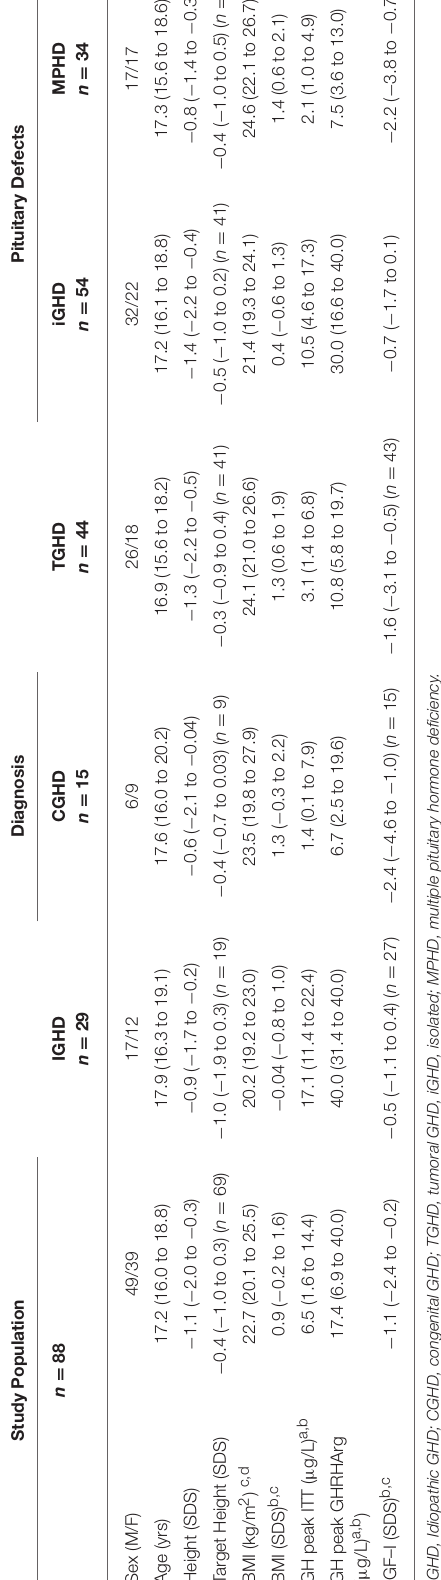
There was a significant inverse correlation between BMI SDS and GH peak responses to GHRHarg ( r = − 0.43, p < 0.0001) when considering the entire cohort; a similar correlation ( r = − 0.43; p = 0.003) was found in TGHD patients. Based on these findings ROC curves were adjusted for either BMI or BMI SDS, showing that obesity could be a confounder ( = lower peak) in interpreting the GH response in obese patients with MPHD (AUC 0.78 vs. 0.84; 95% CI, 0.67–0.89, and AUC 0.79 vs. 0.84; 95% CI, 0.68–0.89, respectively) (data not shown). A significant inverse correlation between BMI SDS and GH peak response was also found after ITT ( r = − 0.43, p < 0.0001) in the whole cohort and in TGHD ( r = − 0.33; p =